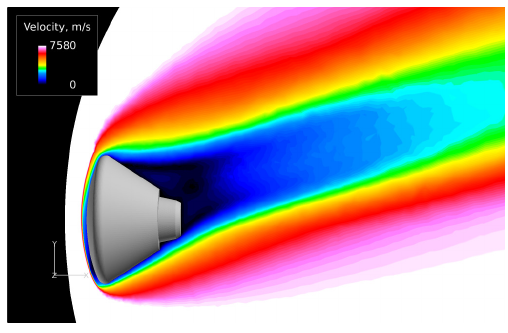
Figure 10. Velocity magnitude distributions around the ESA ARD at an altitude of 85 km ( x - y